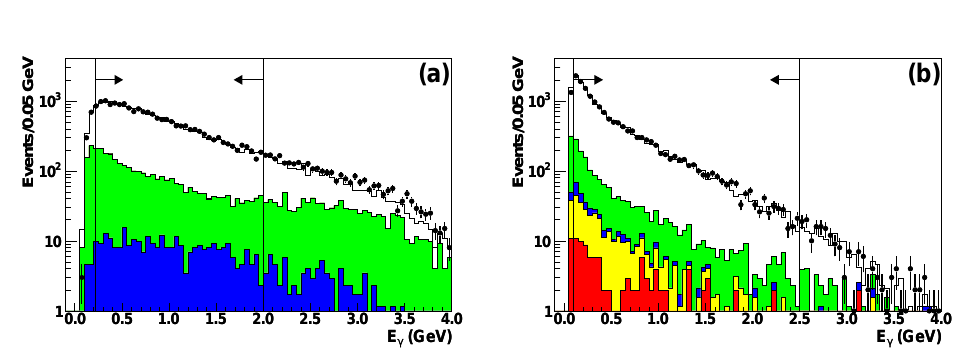
Figure 2. Photon energy in the CM frame: (a) for the τ → e ν ¯ νγ mode, (b) for the τ → µν ¯ νγ mode.